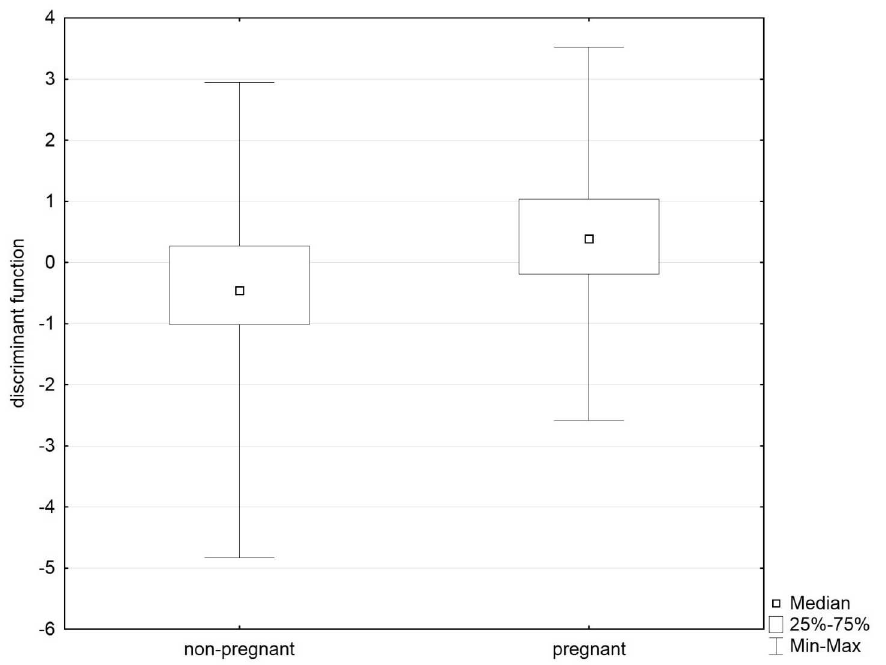
Figure 1. Values of the discriminant function for the groups with pregnancy and without pregnancy